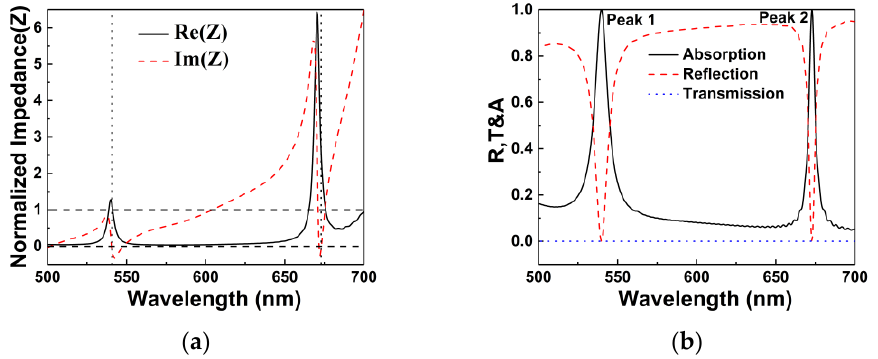
Figure 2. ( a ) Normalize impedance of the proposed absorber. ( b ) Reflection, transmission, and absorption spectrum.